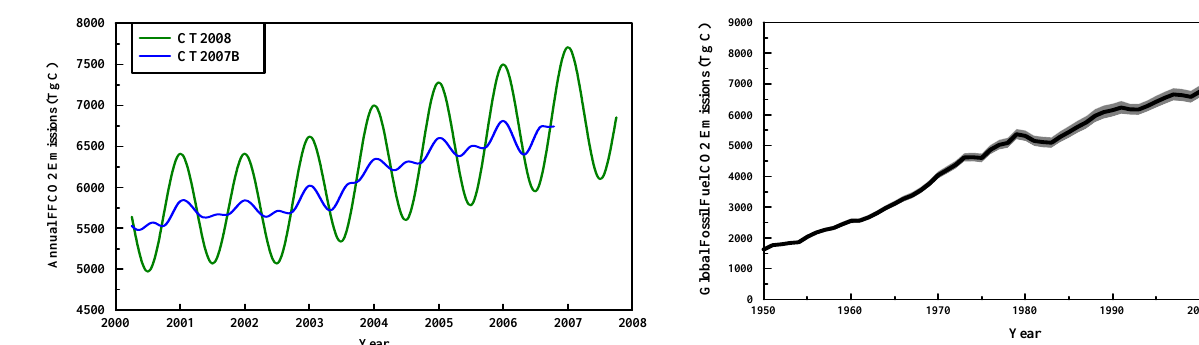
Fig. 6b. Comparison of FFCO2 emissions from two CT simulations for the CT Northern Land region (between 30 o N and 60 o N). The first CT release, CT2007B, includes seasonality for North America only (the remainder of the globe used a smooth curve without seasonality). The latter CT release, CT2008, includes seasonality for all land masses. The two curves differ only in the seasonality imposed on the annual totals (see manuscript text for details on the seasonality imposed). The imposition of seasonality to the annual fluxes preserved the exact same annual totals in both schemes. Data from Jacobson (unpublished data).